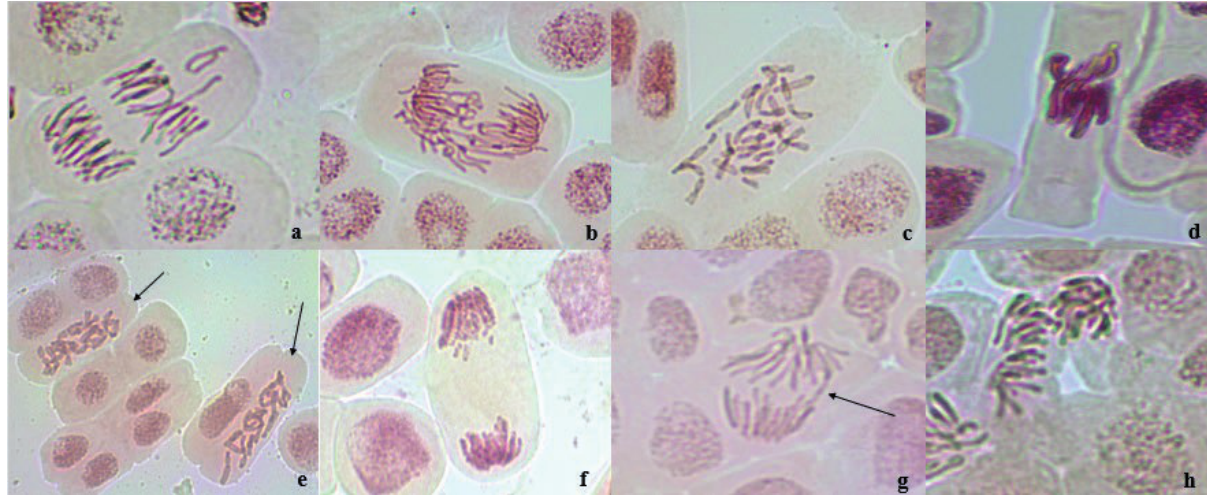
Figure 14. Chromosomal aberrations found in A. cepa root tip meristematic cells following treatments with simple extracts and with extracts supplemented with MNPs (a – Vagrant in EtOH_50; b – Laggards in M_UAE_10_70_AgCl; c – C-mitosis in M_UAE_10_70_AgCl; d – Sticky chromosomes in M_MAE_10_70_AgCl; e – Pole-to-pole metaphase in S_UAE_10_70_Au; f – Cell with fragmented chromo-